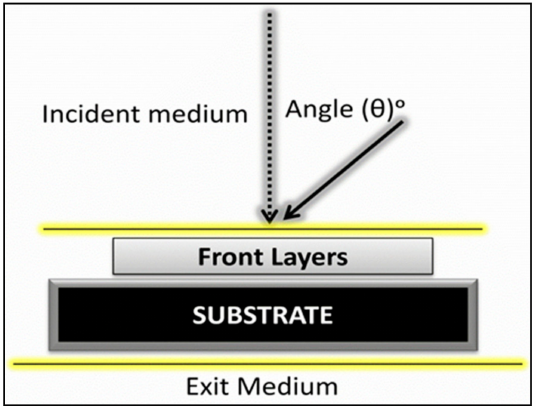
Figure 1. Schematic environmental conditions for the modeling of antireflective (AR) coatings on